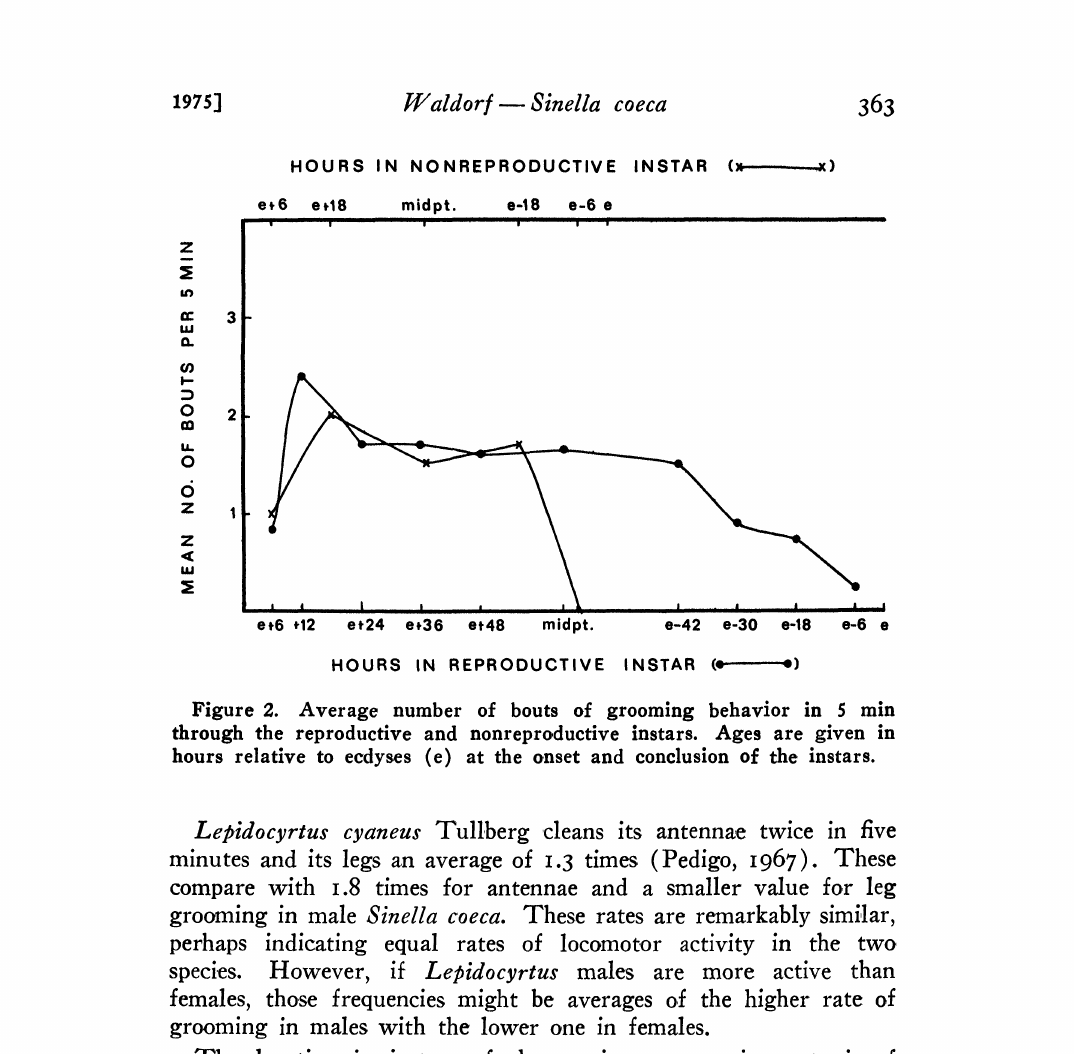
Figure 2. Average number of bouts of grooming behavior in 5 min through the reproductive and nonreproductive instars. Ages are given in hours relative to ecdyses (e) at the onset and conclusion ot the